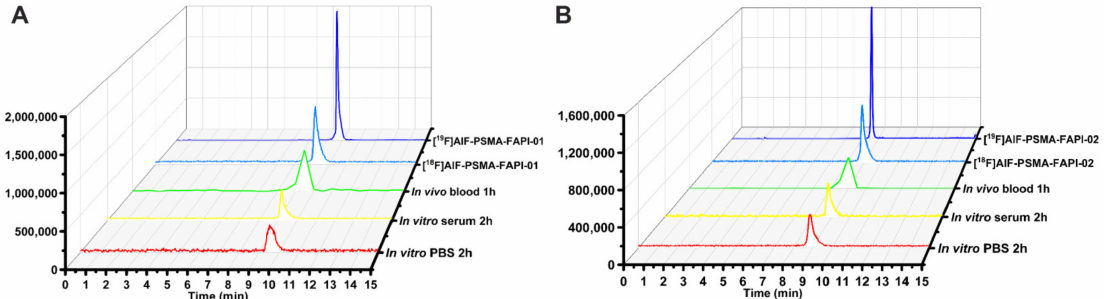
Figure 2. Identification and stability of [ 18 F]AlF-PSMA-FAPI-01 ( A ) and [ 18 F]AlF-PSMA-FAPI-02 ( B ). HPLC analysis of stability in PBS and human serum after incubation at 37 ◦ C for 120 min and in mouse blood at 60 min p.i. The quality control radioactive chromatography of [ 18 F]AlF-PSMA-FAPI-01 and [ 18 F]AlF-PSMA-FAPI-02, as well as the UV chromatography of the standard [ 19 F]AlF-PSMA-FAPI-01 and [ 19